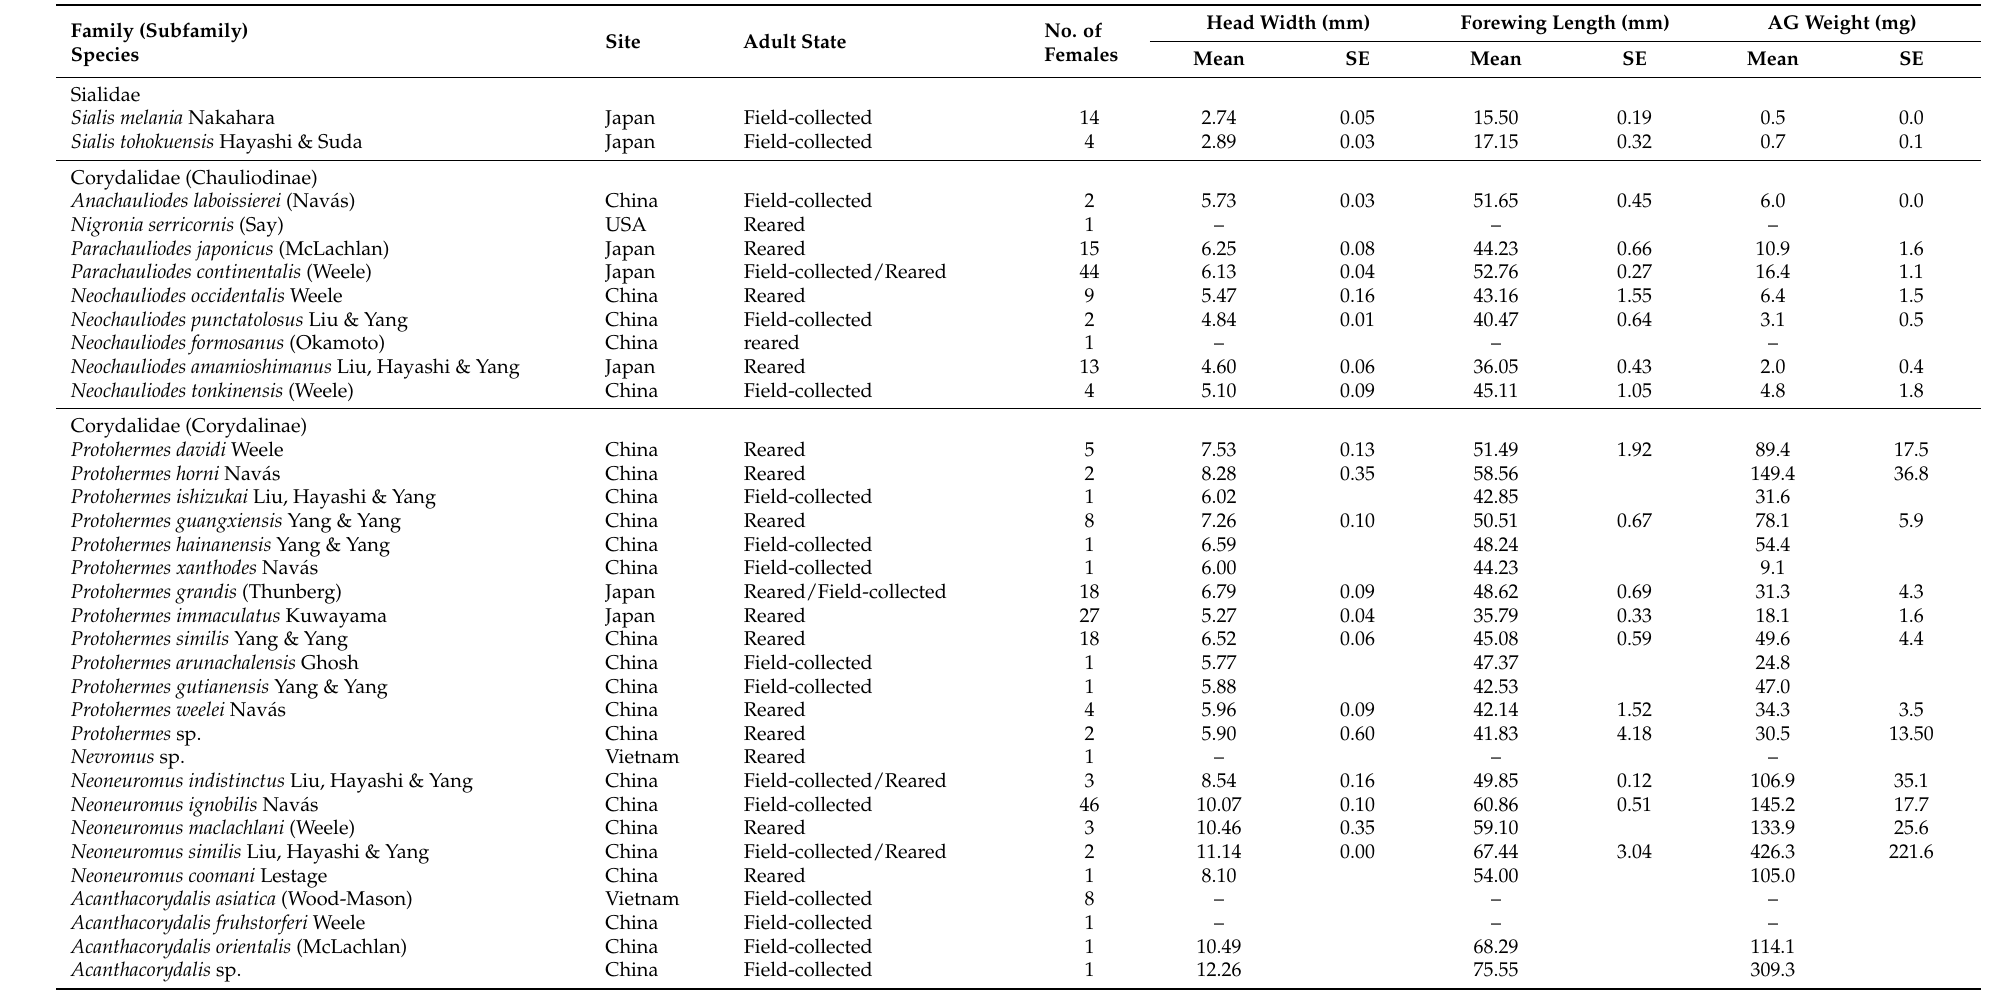
Table 1. Information on species examined in this study with the mean and standard errors (SEs) of the head width, forewing length, and weight of accessory glands (AGs) in the field-collected females and/or those reared from the field-collected larvae. –: not